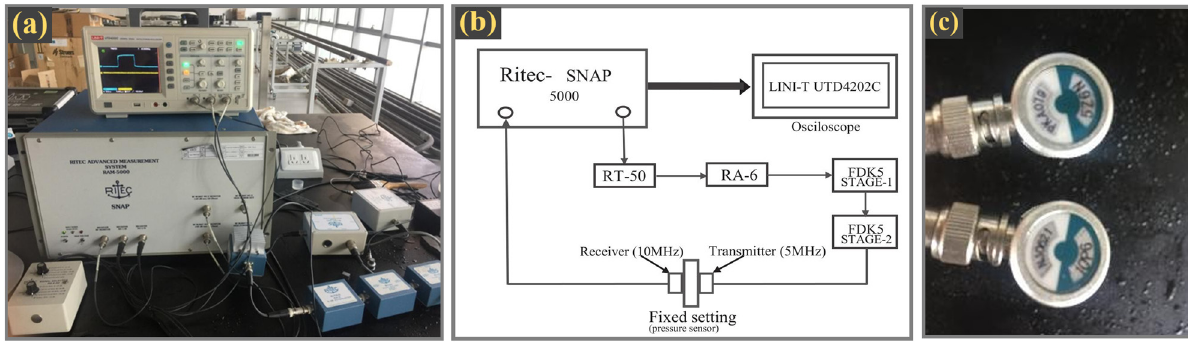
Figure 1: Diagram of nonlinear ultrasonic measurements of TP347HFG steels.